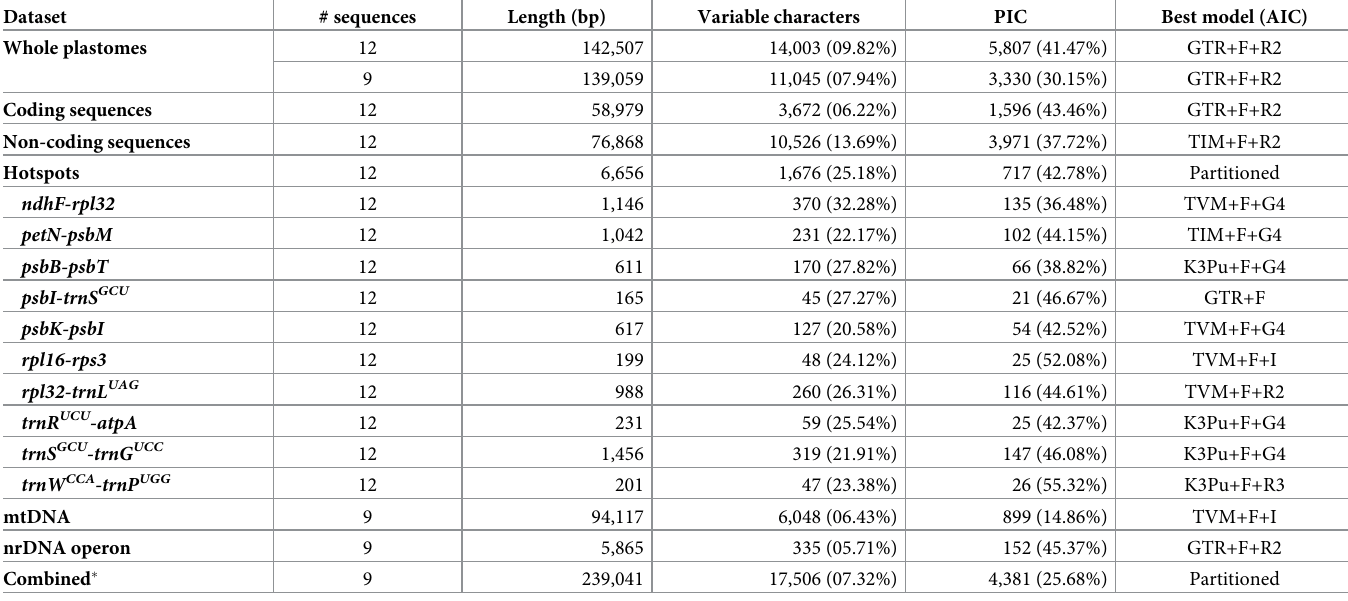
PIC = parsimony-informative characters. � Plastome + mtDNA + nrDNA